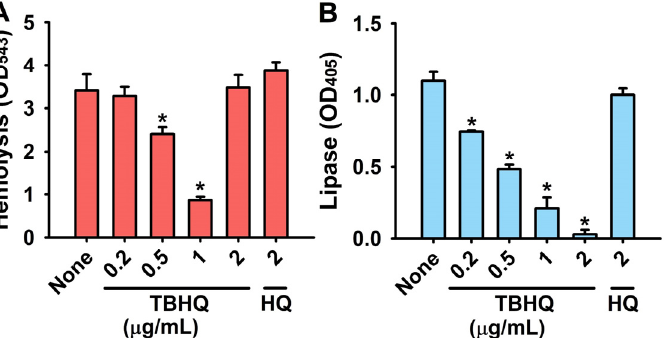
Figure 3. Inhibitory effects of TBHQ on virulence factors in S. aureus . Anti-hemolytic activity ( A ) and extracellular lipase production ( B ). MSSA 6538 was used for these assays. Error bars indicate standard deviations. * p < 0.05 vs. non-treated controls (None).